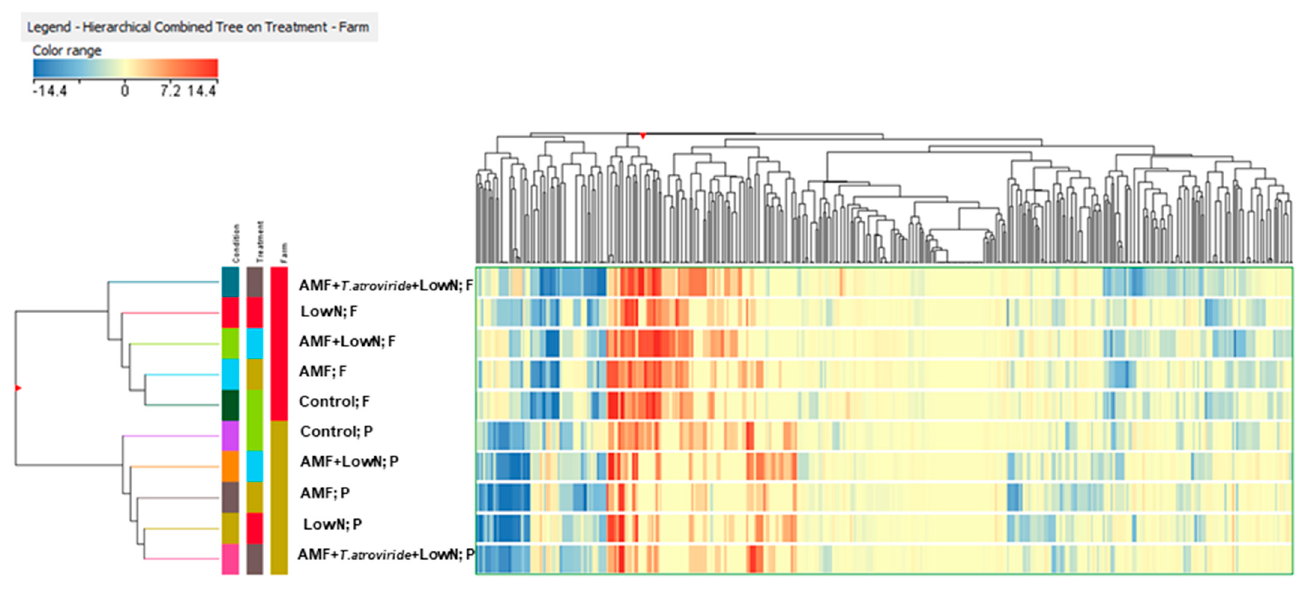
Figure 1. Unsupervised hierarchical cluster analysis (Euclidean distance; linkage rule: Ward) of tomato fruits phenolic profiles amid Control, LowN, AMF, AMF + LowN and AMF + T. atroviride + LowN treatments at optimal (P) and sub-optimal (F) fertility. Metabolites were obtained by UHPLC − ESI/QTOF − MS untargeted analysis, and their intensities were used to create the fold − change heatmap provided here. Table 7. Semi-quantitative content of different phenolic classes in tomato fruits from plants grown under low nitrogen fertilization regimen, treated with different biostimulants at the site with sub- optimal soil fertility. The data are presented as cumulate abundance of individual compounds gained from untargeted metabolomics profiling and were elaborated by one-way analysis and Duncan